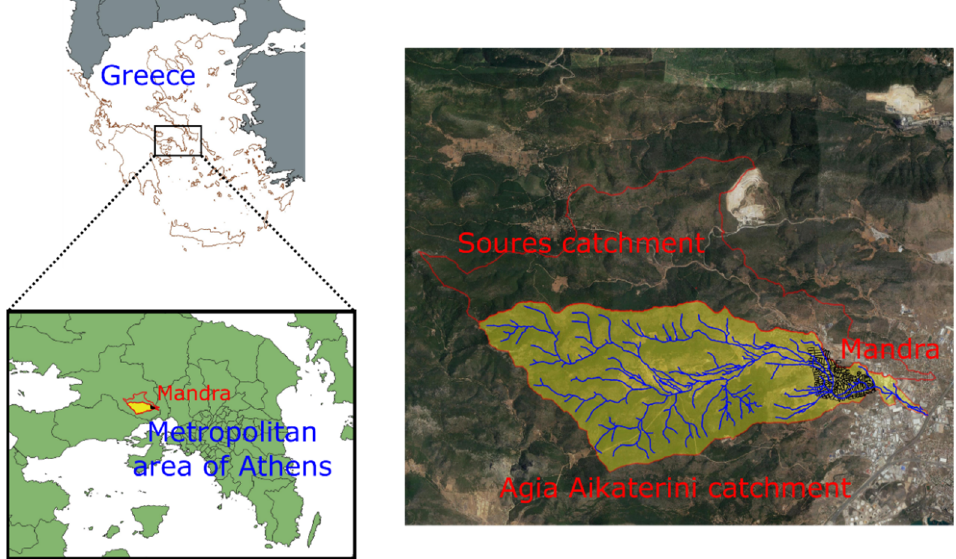
Figure 1. General location of Mandra town and the Agia Aikaterini and Soures catchments.